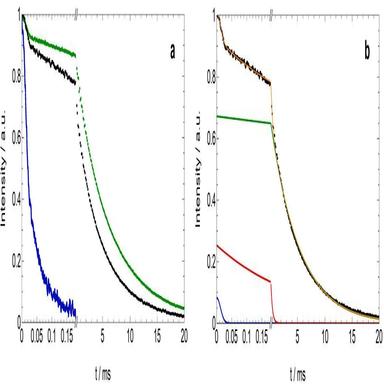
(a) 1 H MSE FID of mSep (blue) and combined MSE/CPMG relaxation curves of NR (green) and vulcanized MB-mSep+SiO2/NR (black). (b) Experimental (black) and best-fit (orange line) MSE/CPMG relaxation curve of vulcanized MB-mSep+SiO2/NR. Together with the total fitting function (orange line) and the single contributions of the Gaussian (blue line), intermediate-T2 (red line), and long-T2 (green line) exponential functions are shown. (For interpretation of the references to colour in this figure legend, the read